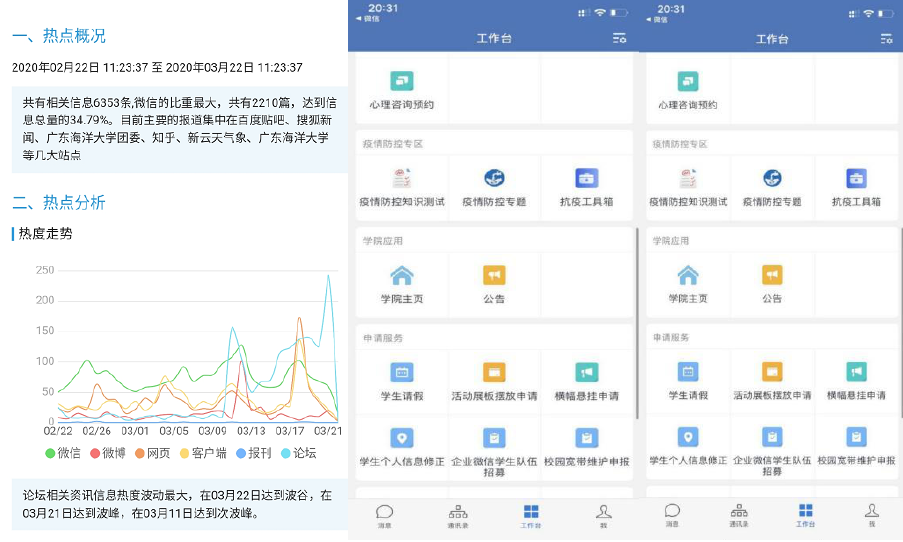
Fig. 1. Functions of office services. Fig. 2. Workbench of Student Mobile Service